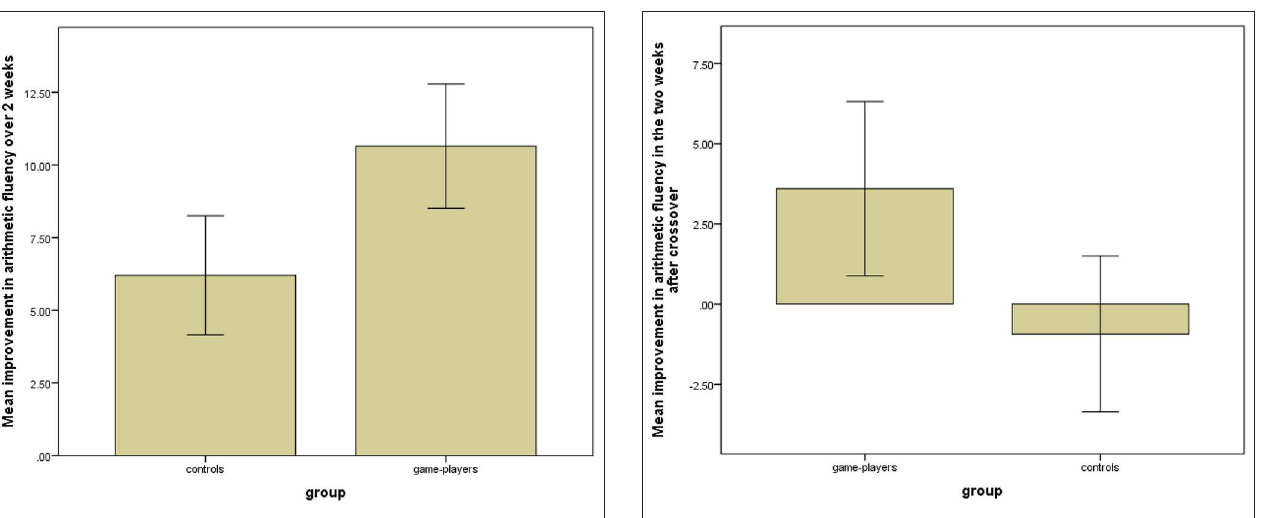
FIGURE 3 | Mean improvement in arithmetic fluency by group for 2-week intervention (error bars represent ± 2 SE).